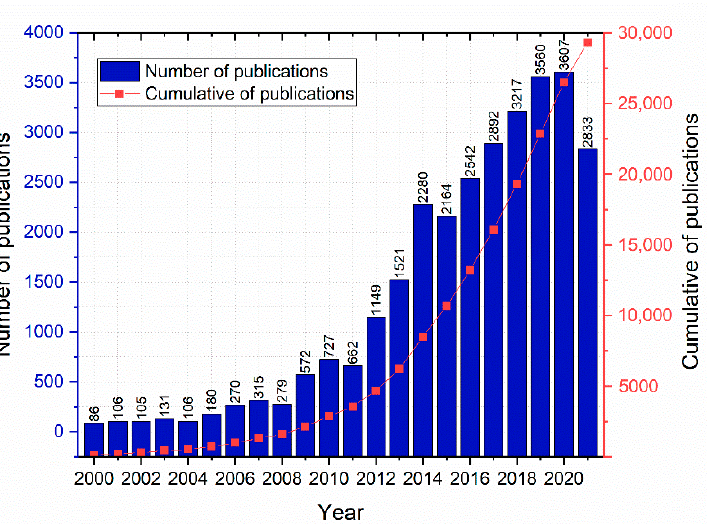
Figure 2. Quantitative distribution of publications in electric vehicle studies, 2000–2021.